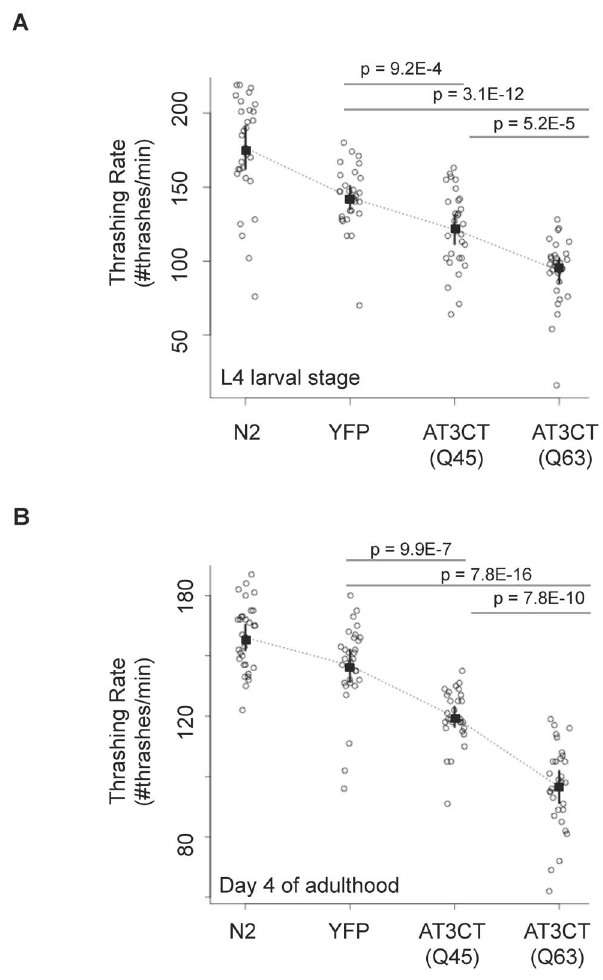
Figure 3. The toxic effects of AT3CT expression in C.elegans body wall muscle cells. Motility was determined as a measure of thrashing rate in liquid for L4 larvae (A) or animals at day 4 of adulthood (B). All 30 individual data points are represented on a dot blot. The symbol ‘‘ & ’’ represents means. 95 percent confidence intervals are indicated. P-values are the results of pairwise student